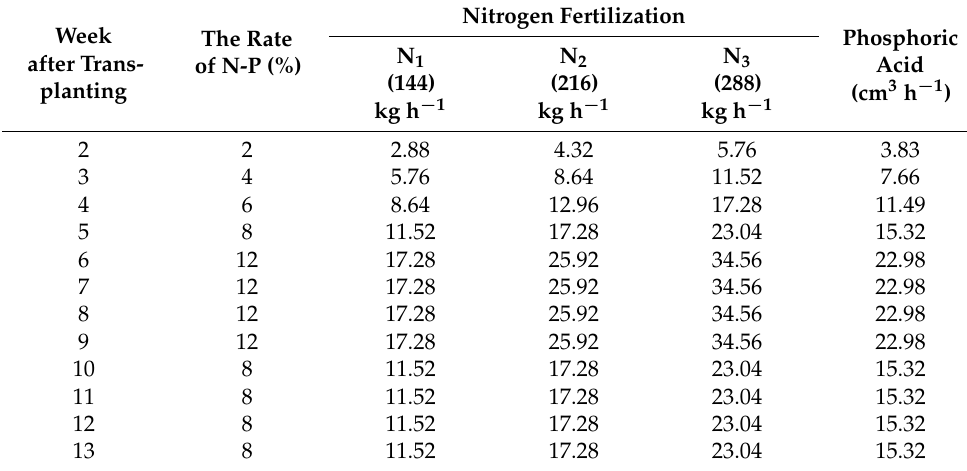
Table 10. Schedule of fertigation system applied for nitrogen and phosphorus fertilization of hot pepper plants grown in sandy loam soil under greenhouse in the two growing seasons of 2017 and